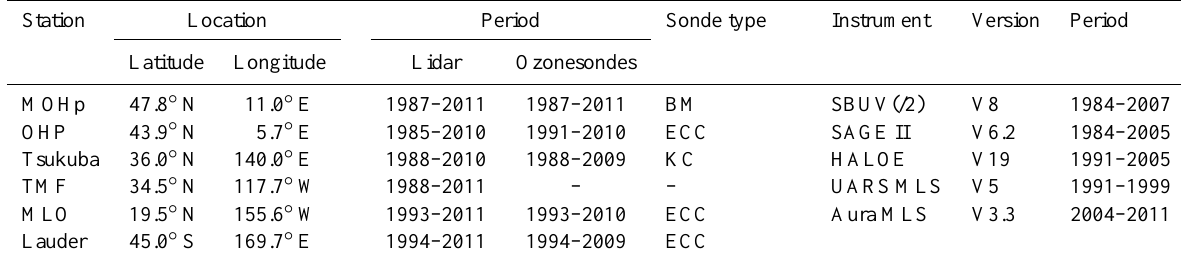
Table 1. Various NDACC lidar stations, their locations, the period of observations of lidar and the analysis period and type of ozonesondes [Electrochemical Concentration Cell (ECC), Japanese KC and Brewer-Mast (BM)] used in this study are given. The satellite data sets utilised for the study, their retrieval version and analysis periods are also noted. Station Location Period Sonde type Instrument Version Period